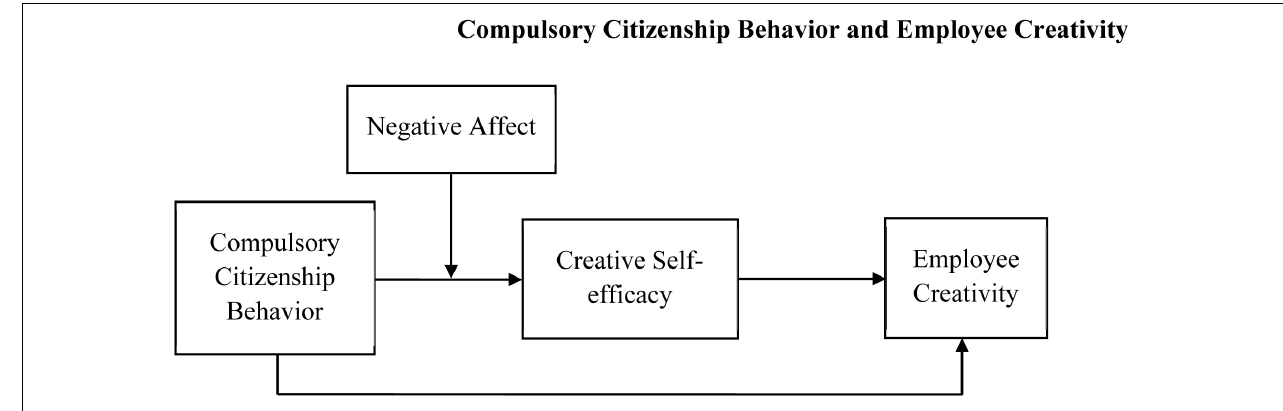
FIGURE 1 | Hypothesized moderated mediation model of processes linking CCB and employee creativity. CCB, compulsory citizenship behavior.